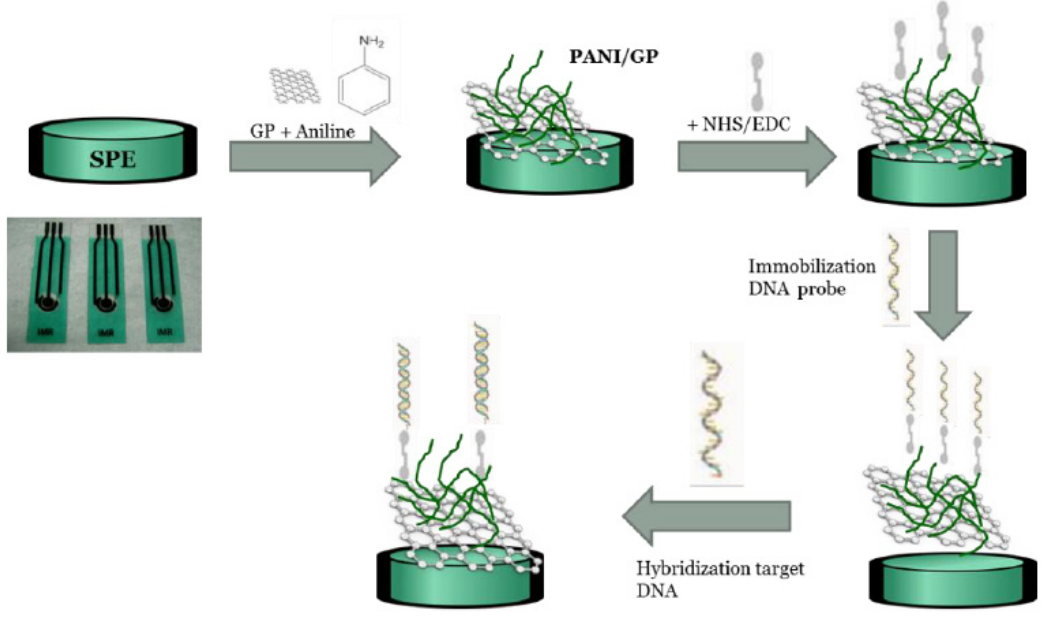
Figure 6. Schematic illustration of the stepwise electrochemical fabrication process for DNA biosensor. Reproduced with permission of [133], Copyright 2017, MDPI. Table 4. Comparison of conducting polymer-based DNA biosensor performances.